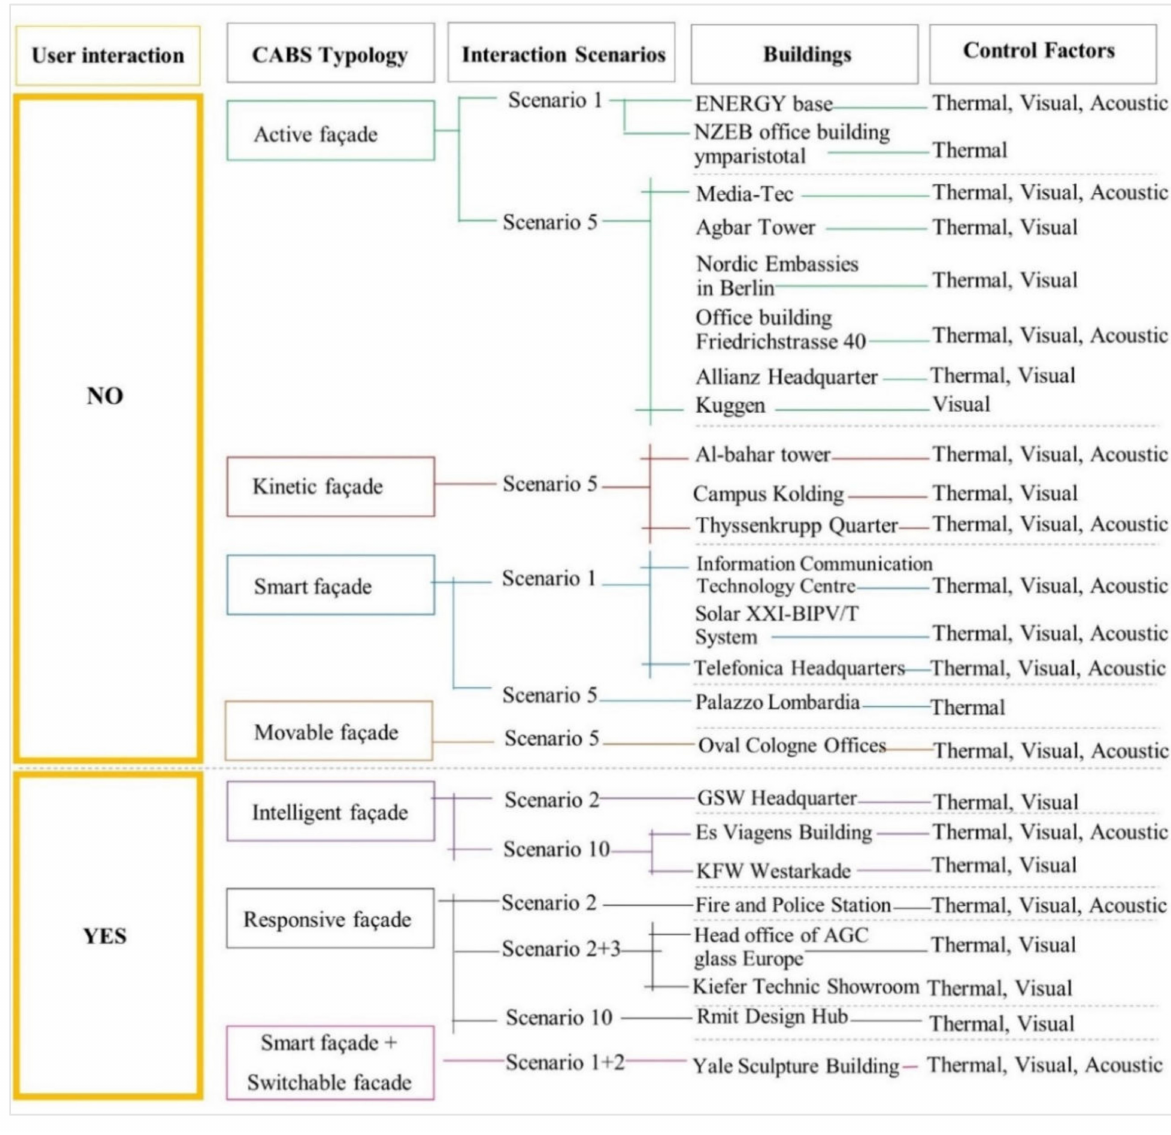
Figure 11. Multidomain taxonomy of CABS office buildings (Authors,